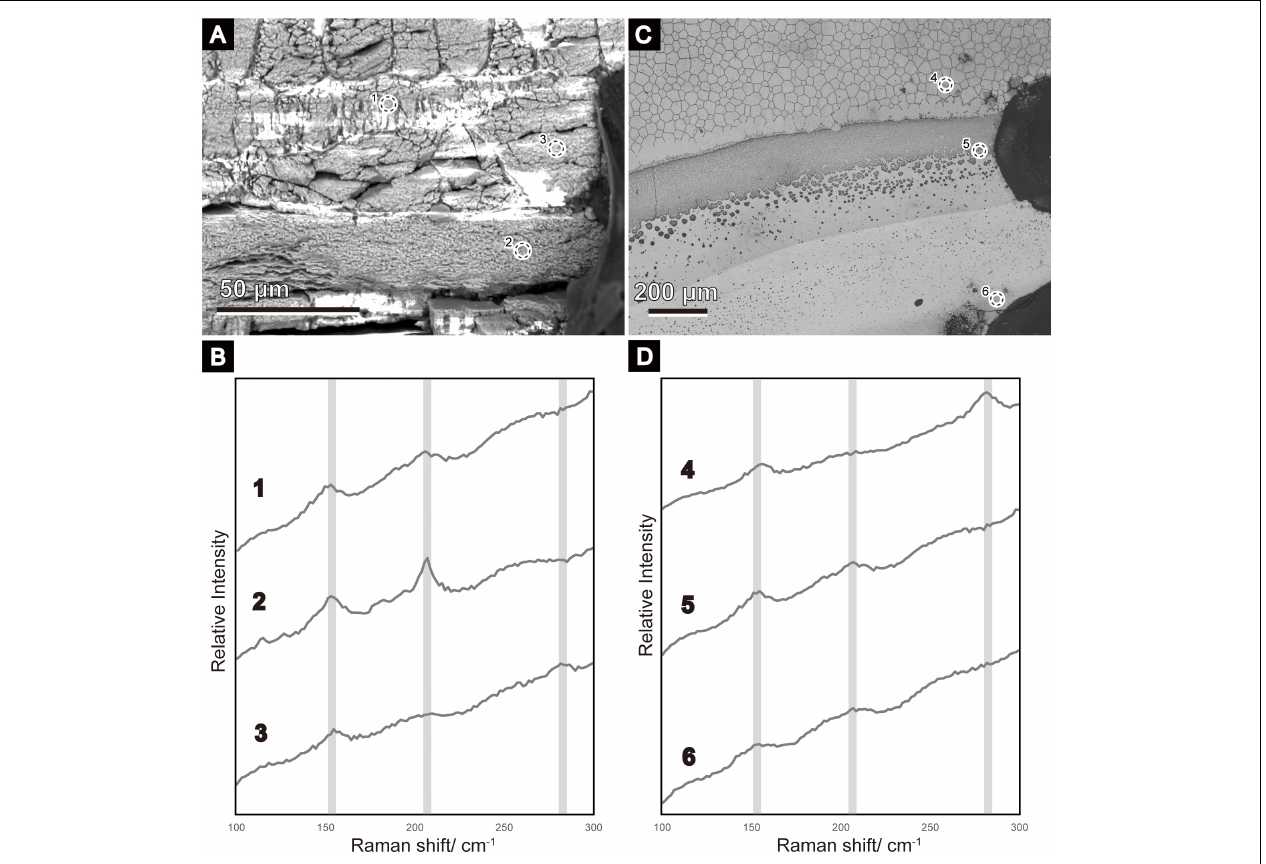
FIGURE 2 | Scanning electron micrographs (A,C) of the areas where Raman analyses were conducted, and the resulting Raman spectra (B,D) . The broken-lined circle roughly indicates the part from which the Raman spectra were acquired (1–6). (A) Radial section of ID 180226-1. A similar position before re-polishing to remove evaporated gold for Raman analysis is shown in Figure 4B . A carbon tape was attached to the right as a landmark. (B) Inner shell surface of ID 180226-1 ( Figure 5A ). Dots on the right side were used as landmarks. (B,D) Raman spectra of calcitic columnar regular simple prismatic structures are indicated by 3 and 4; the sheet nacreous structure is indicated by 2; the winter diffusion layers are indicated by 1, 5, and 6. Aragonite peaks (152, 205) are clear in 1, 2, 5, and 6, whereas calcite peaks (154, 280) are detected in 3 and